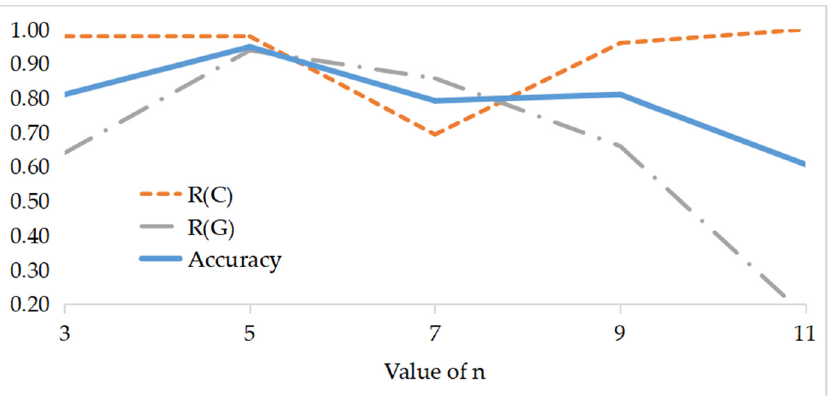
Figure 8. The accuracy, recall rate of coal (R(C)) and recall rate of gangue (R(G)) tested on Dataset2 for different values of n. Table 3. Accuracy.